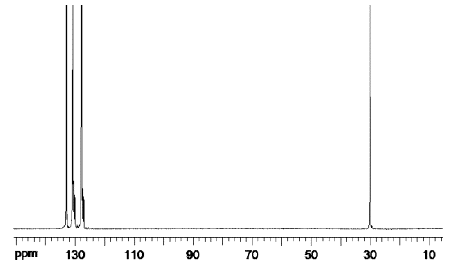
Figure 2. 13 C NMR spectrum of the polyethylene obtained from 1 /MAO (entry 4).